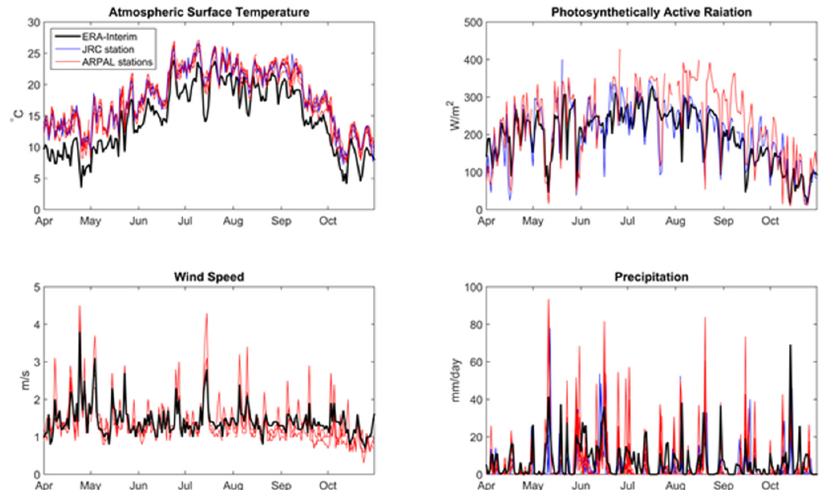
Figure A1. ERA-Interim reanalysis of daily mean data at Lake Varese (black) compared to ground observations in the area of Lake Varese for the period 2004–2014: Surface temperature; photosyntetically active radiation (PAR); wind speed; total precipitation.